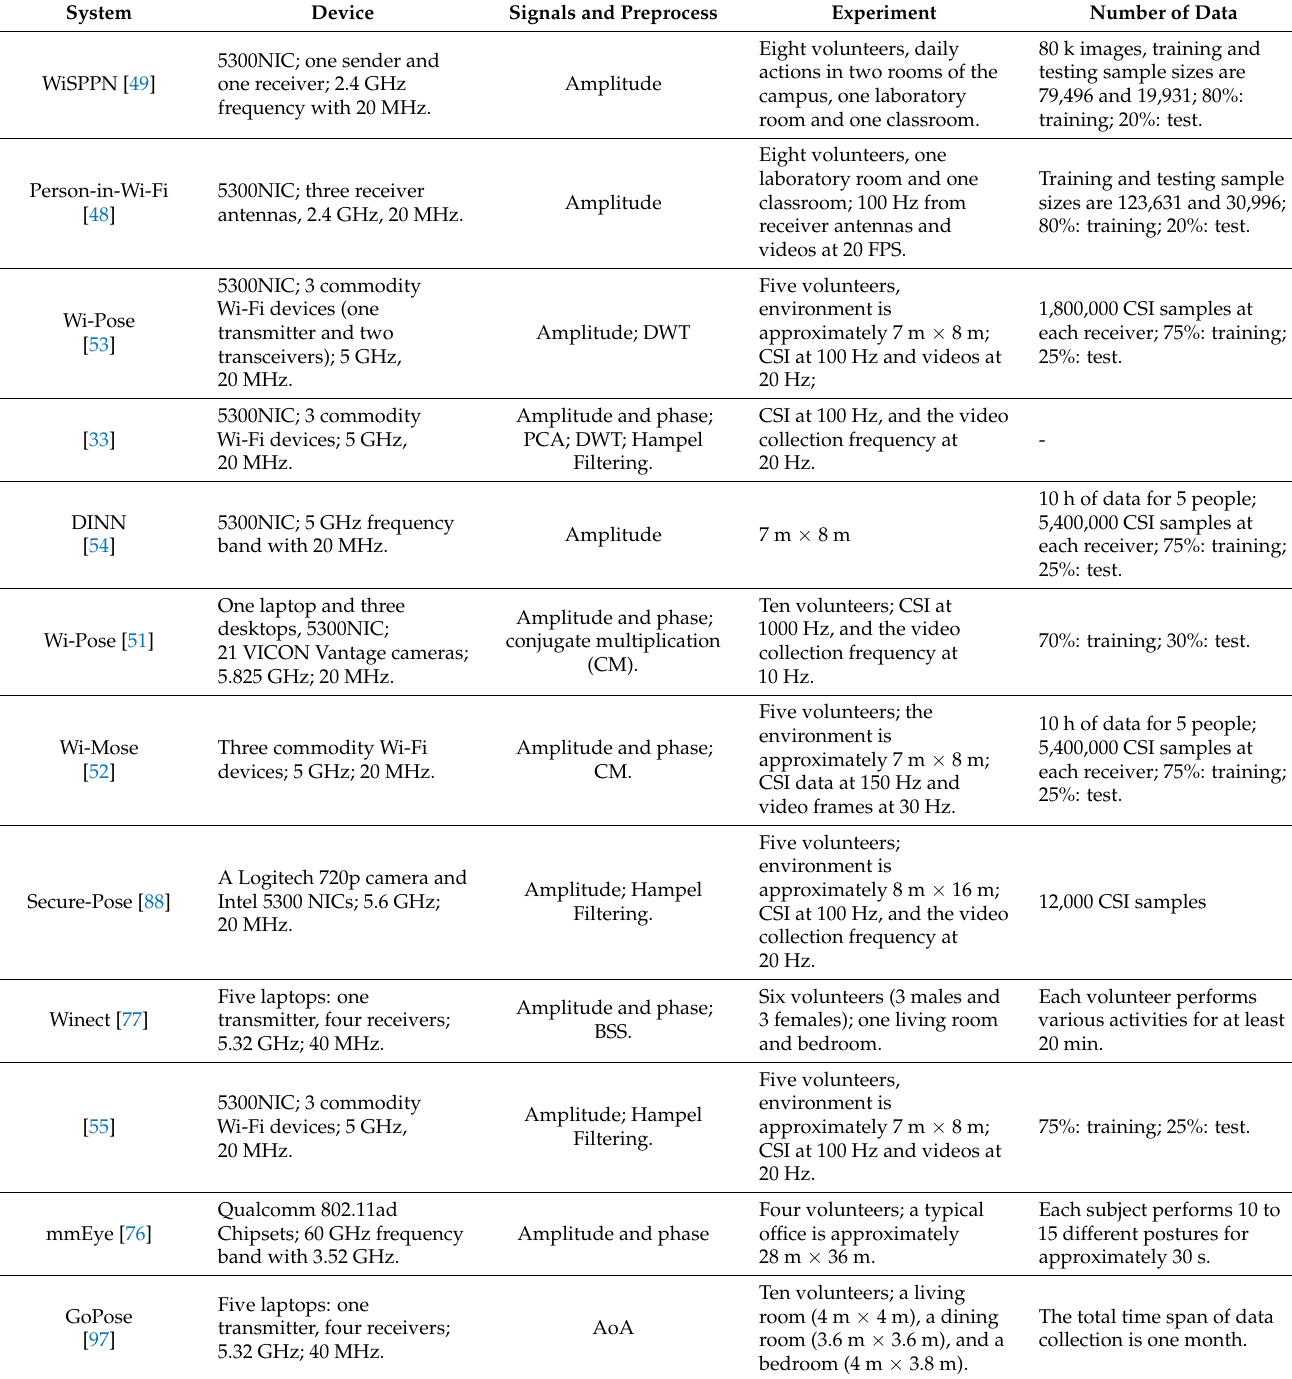
Table 2. Device, Scene, and Data for Signal